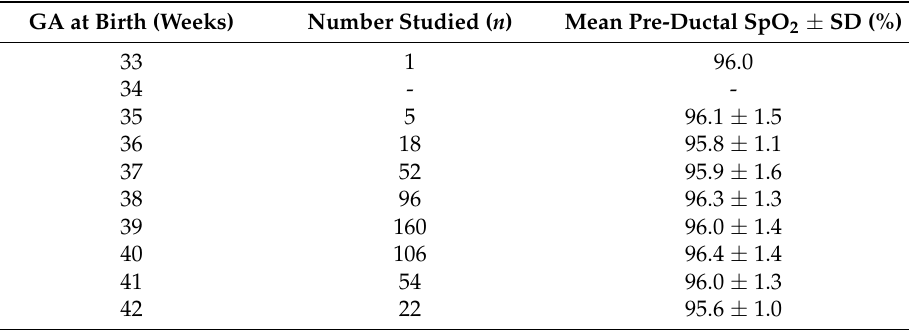
Table 5. The GA at birth and pre-ductal SpO 2 .